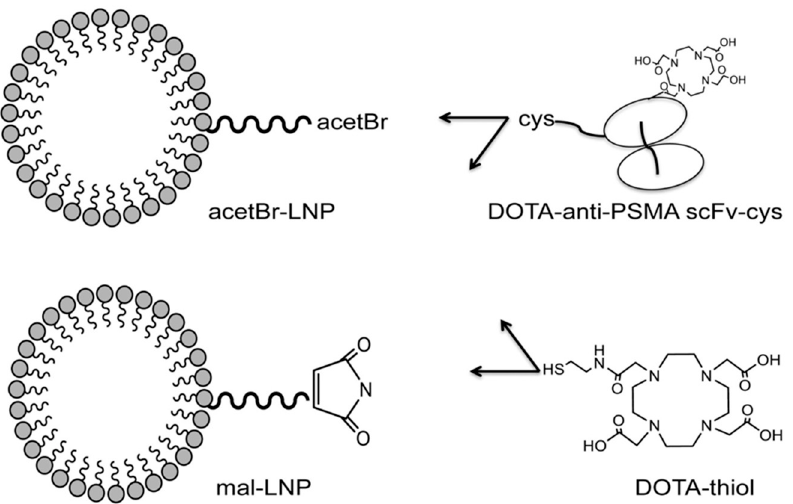
Figure 10. Representative constructs for scFv-conjugated lipid vesicles. Reprinted with permission from Ref [64]. Copyright 2017, Elsevier.